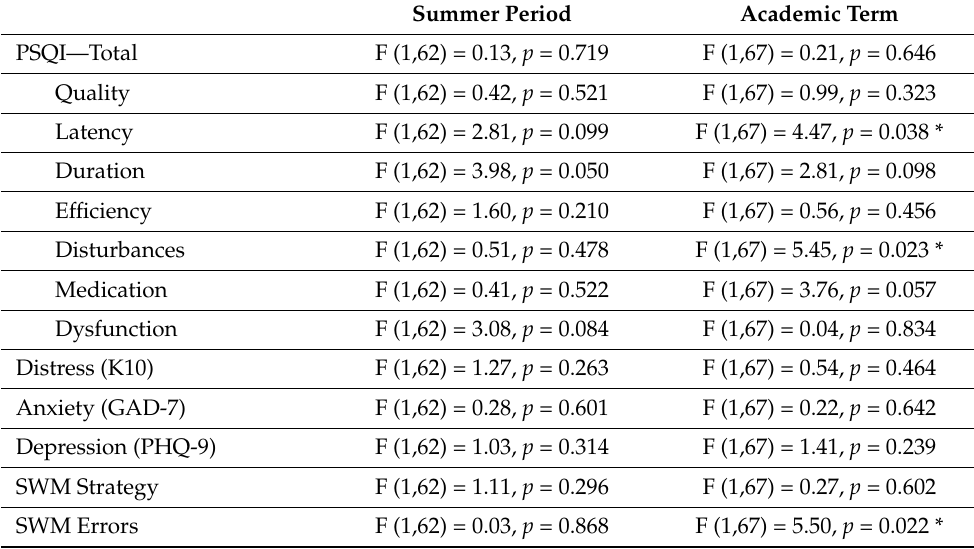
Table 4. Association between sleep quality measures and GPA in the summer period and the academic term. Terms denoted with an asterisk (*) are significant ( p <